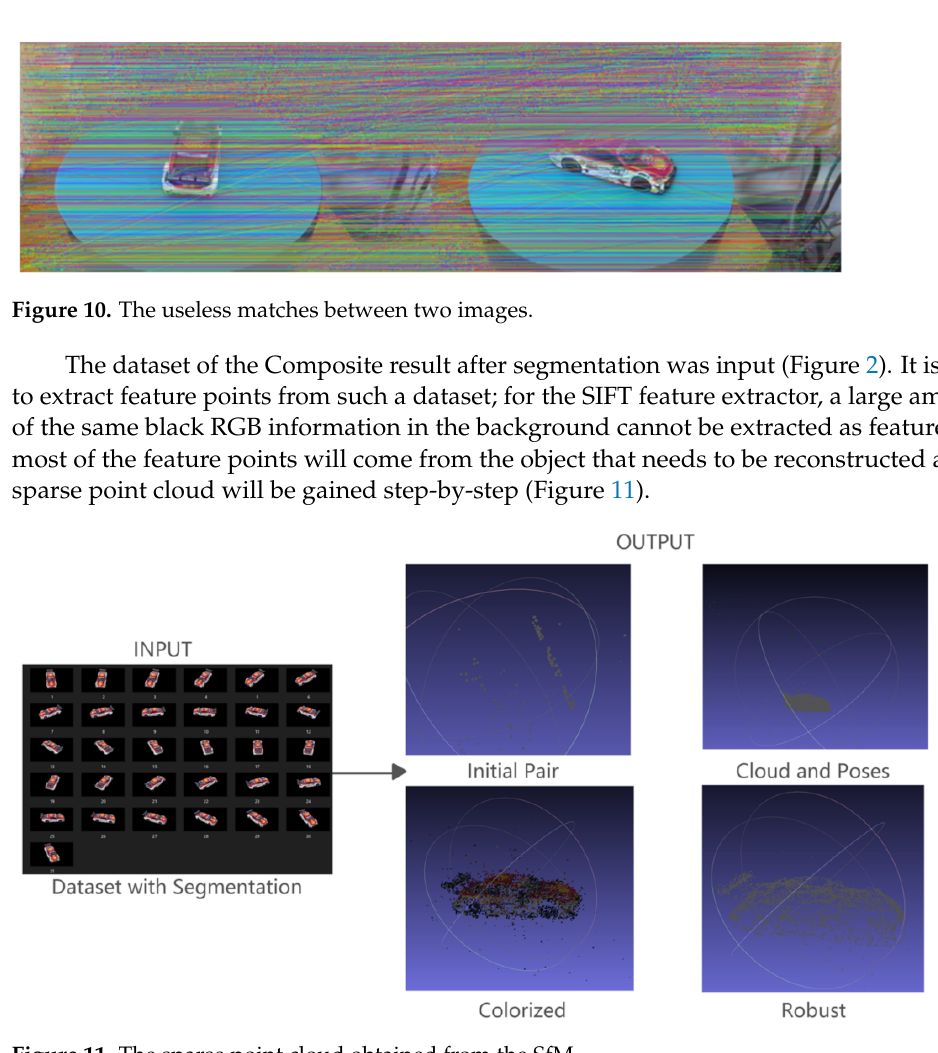
Figure 11. The sparse point cloud obtained from the